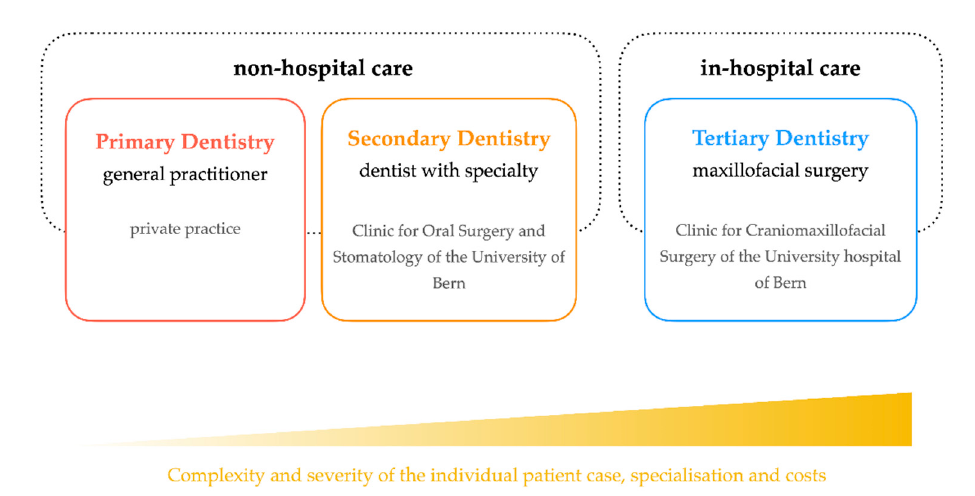
Figure 1. Illustration of the Bern model: Explanation of the terms “primary,” “secondary,” and “tertiary” dentistry.